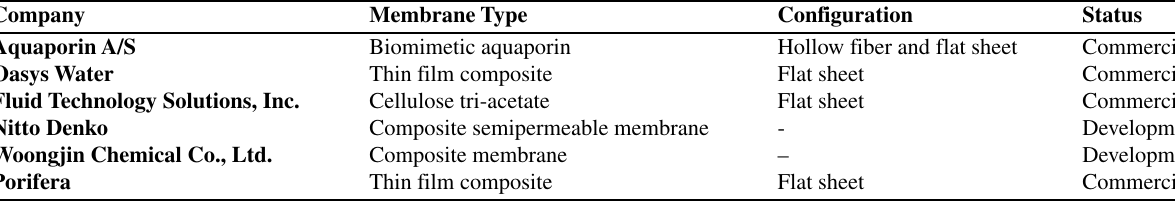
Table 3. List of commercial producers and developers of FO membranes